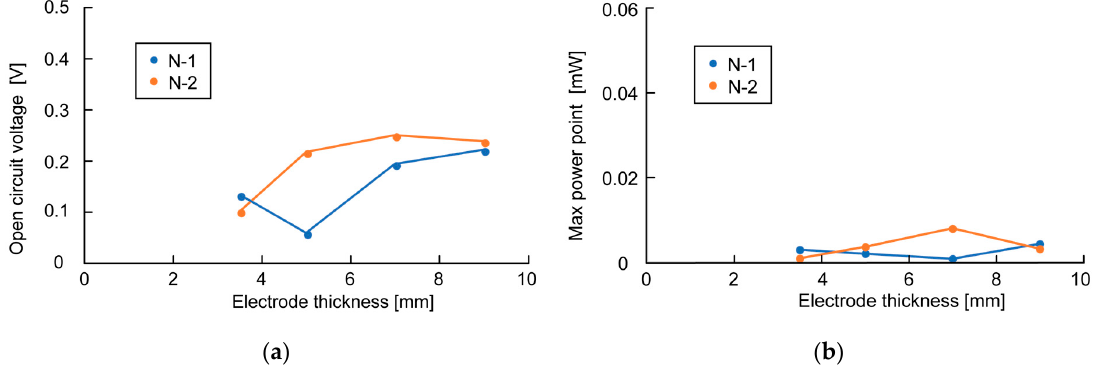
Figure 7. Measurement results of OCV and MPP in the experiment of changing electrode thickness: ( a ) measurement result of OCV; ( b ) measurement result of MPP.